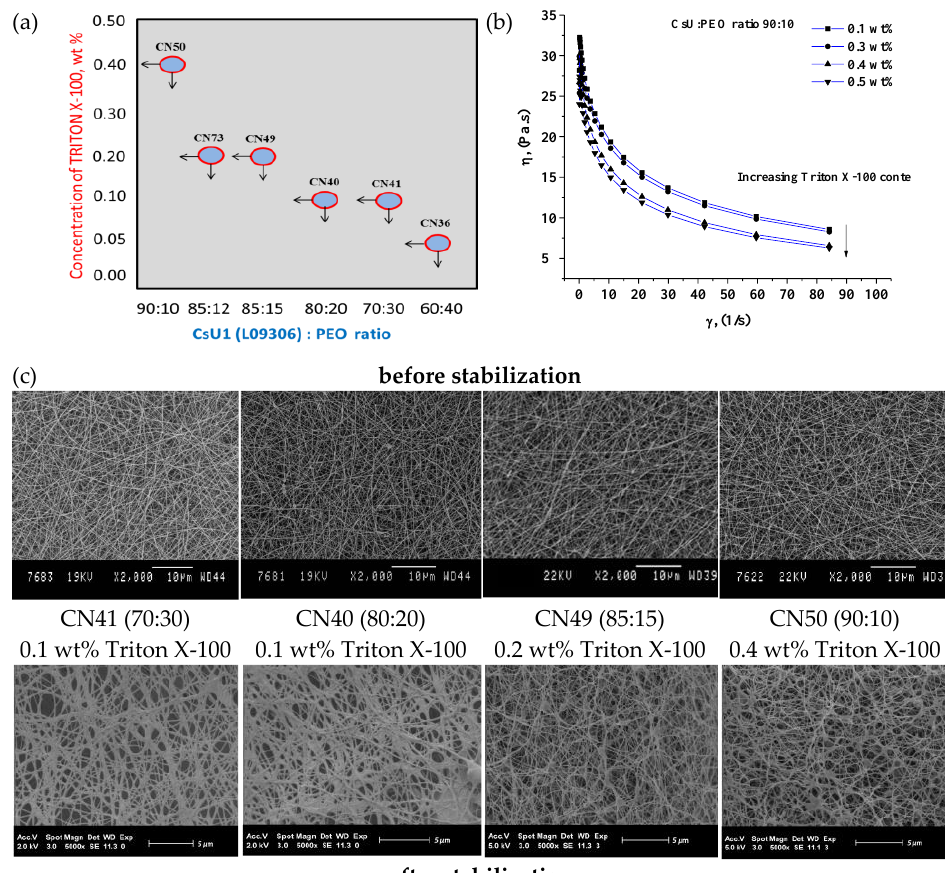
Figure 5. Minimal Triton X-100 concentration for achieving ESP of CsU/PEO solutions of various ratios ( a ); viscosity of CsU1:PEO 90:10 solutions for various Triton X-100 concentration at 25 °C ( b ); ESEM analysis of the collected mat of the corresponding solution (Table 3) ( c ).